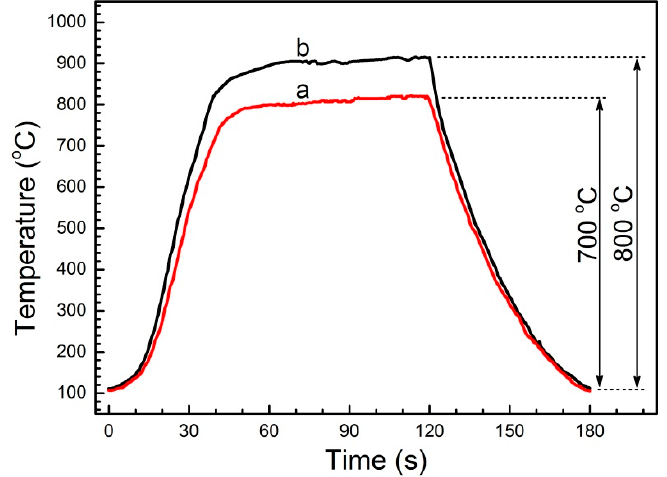
Figure 2. Time dependence of temperature of thermal fatigue cycles test with different T max : ( a ) 800 °C and ( b ) 900 °C.